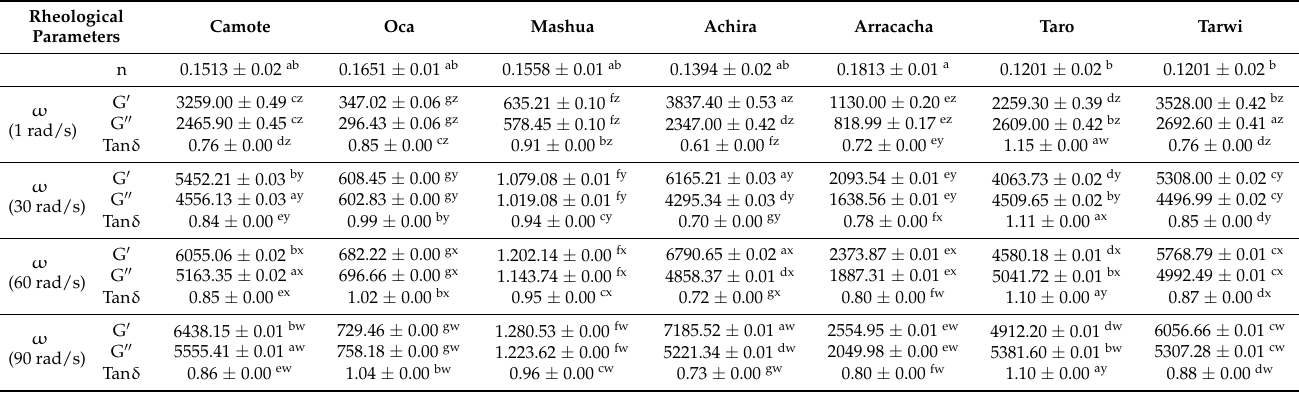
Different letters (a, b, c, . . . ) in the same line indicate significant differences between samples ( p ≤ 0.05). Different letters (w, x, y, . . . ) in the same column indicate significant differences in same sample for each parameter ( p ≤